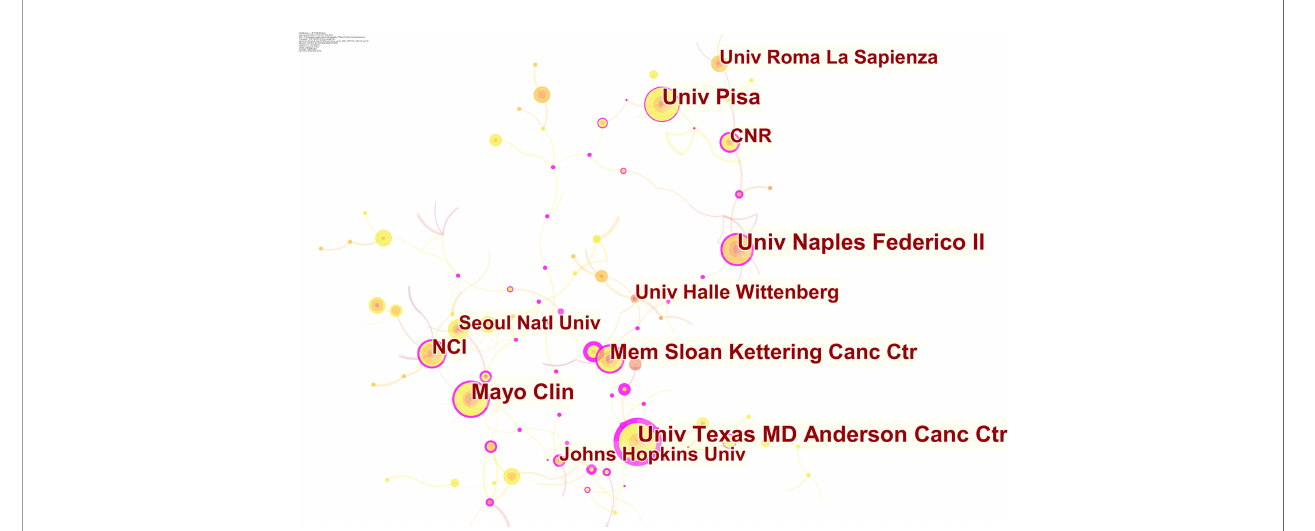
FIGURE 5 | The network of contributed institutions in ATC fi eld.